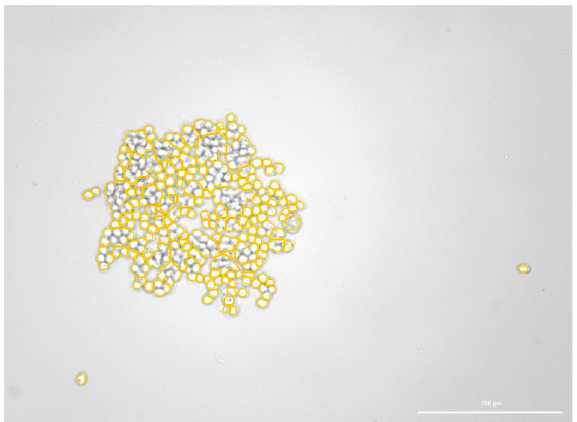
Figure 5. Microscopic image. Group of starving HCT116 cells with free-floating cells removed (bright-field image taken by Cytation 3 Cell Imaging multimode sensor). The scale bar on bottom right of the picture corresponds to 200 µm.